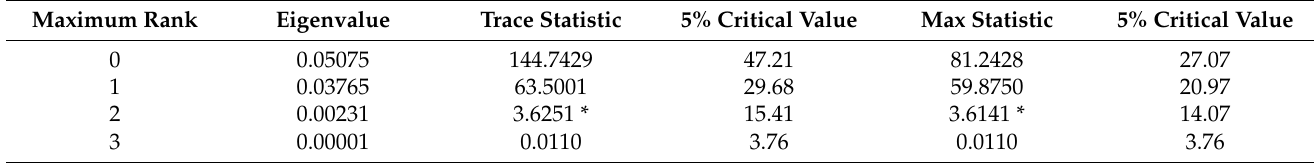
Table 2. The Johansen test of cointegration. Electricity prices: peak and off-peak